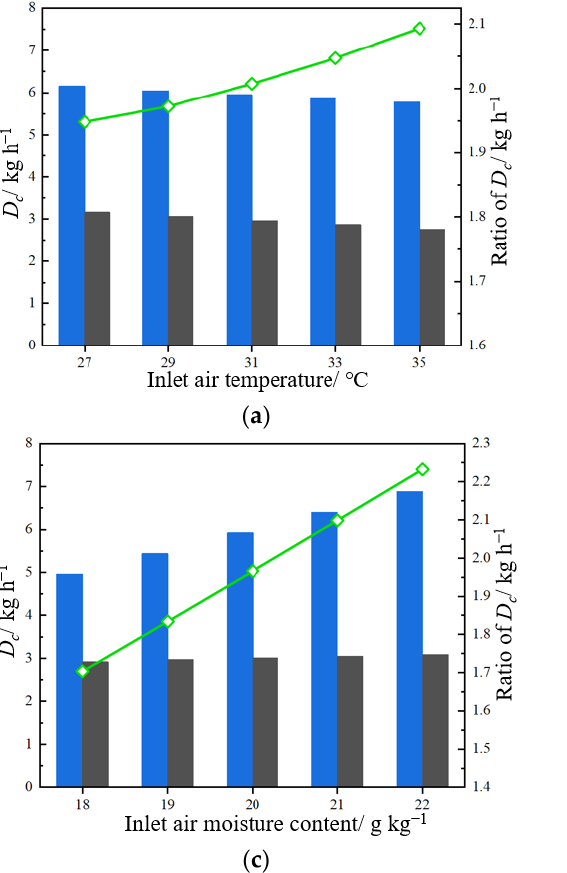
Figure 7. Desiccant wheel dehumidification system (DWDS) and HDS without a separated heat pipe. ( a ) DWDS. ( b ) HDS without a separated heat pipe.